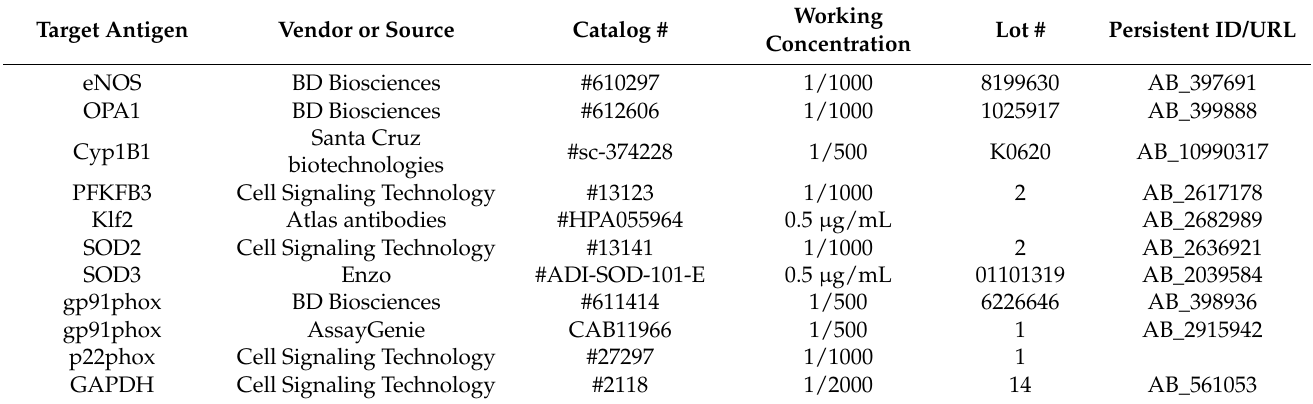
Table 2. List of the antibodies used for the Western-blot